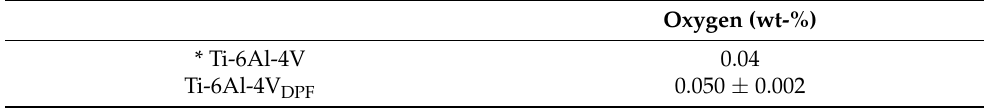
Table 3. Oxygen analysis of the original powder and of the DPF samples.